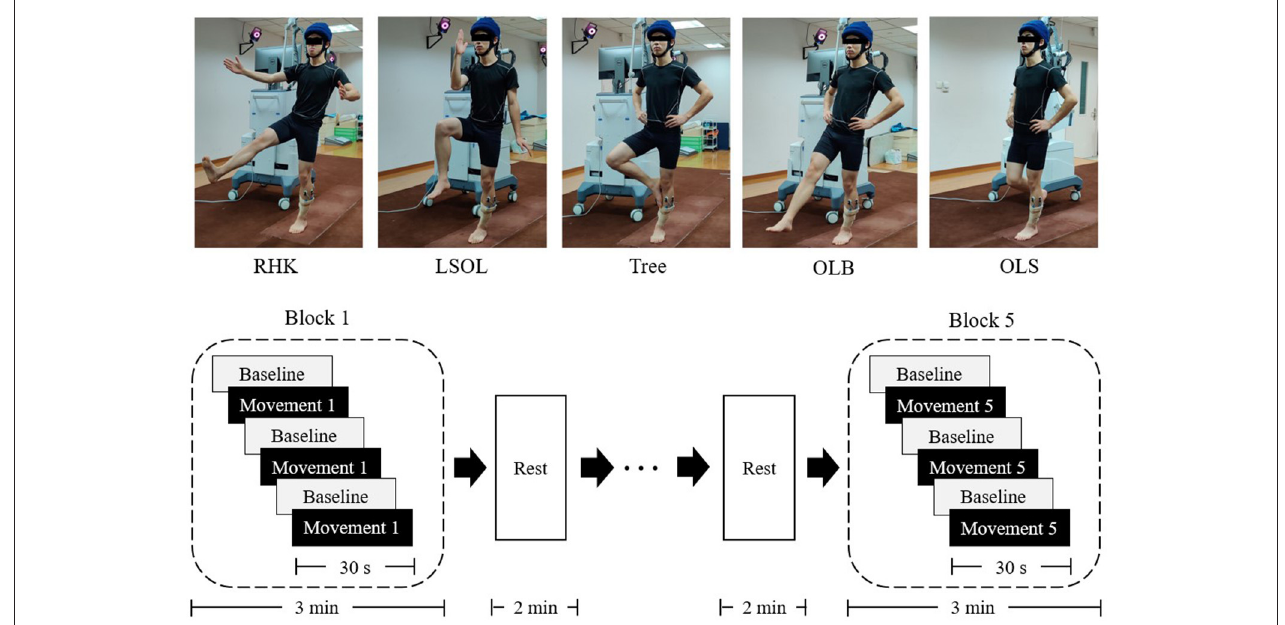
FIGURE 1 | Five one-leg stance postures and experimental procedure. Five one-leg stance postures are shown in the upper panel. RHK, right heel kick; LSOL, left lower body and stand on one leg; OLB, one-leg balance; OLS, normal one-leg standing. Experimental procedure is shown in the lower panel. Baseline (gray rectangles): bipedal standing for 30s; movement (black rectangles): preforming one-leg stance posture for 30s.